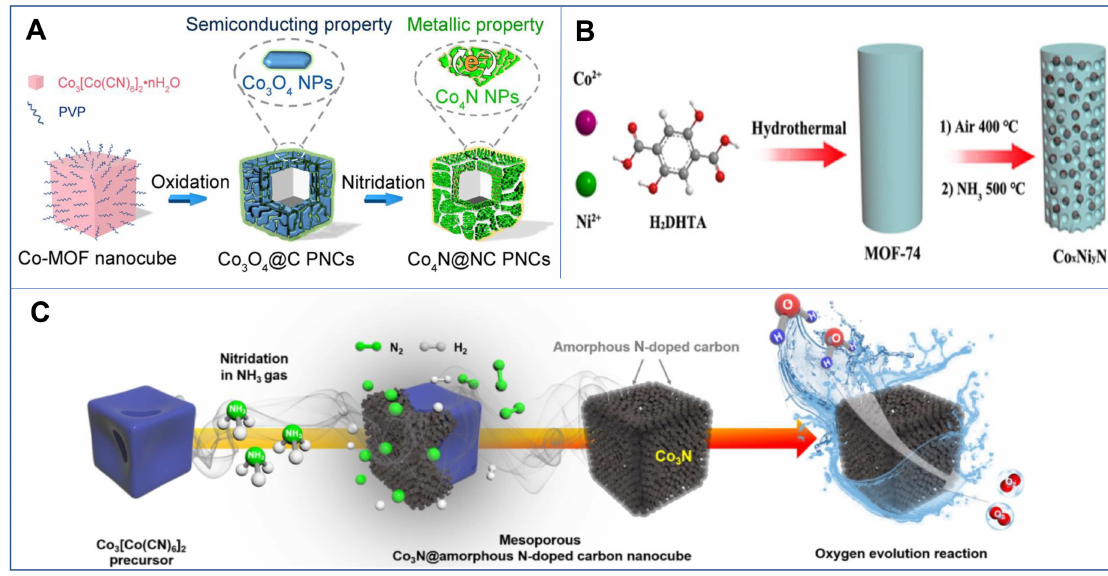
Figure 3. ( A ) Schematic of the synthesis route of Co 4 N@NC PNCs. ( B ) Schematic diagram of the formation of porous Co x Ni y N composites. ( C ) Schematic illustration of the synthesis process of mesoporous Co 3 N@amorphours N-doped carbon NCs. Reproduced with permission from [54–56]. Copyright © 2018 and 2019 American Chemical Society. Copyright © 2019 Tsinghua University